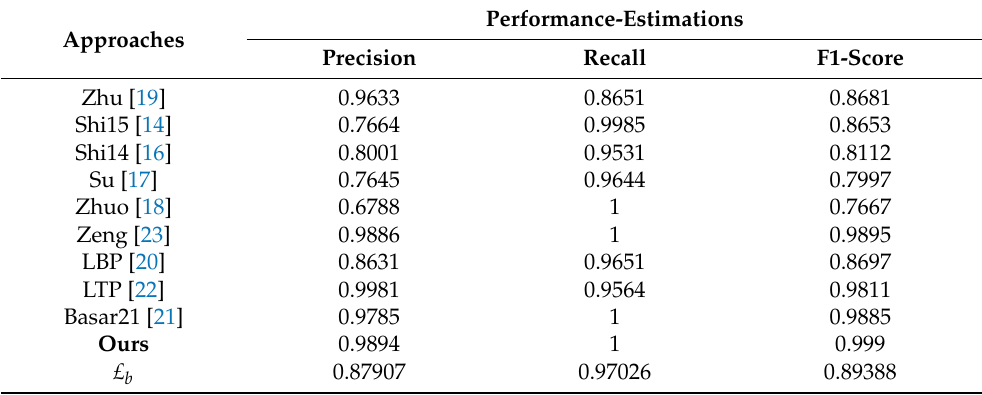
Table 5. Cross efficient Calculated